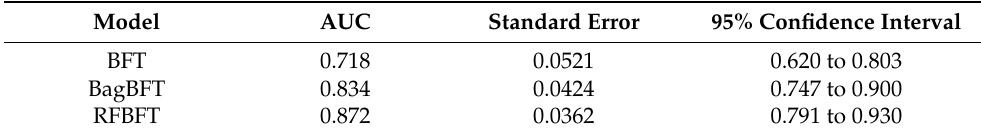
Table 4. Parameters of ROC curves with the validation dataset.